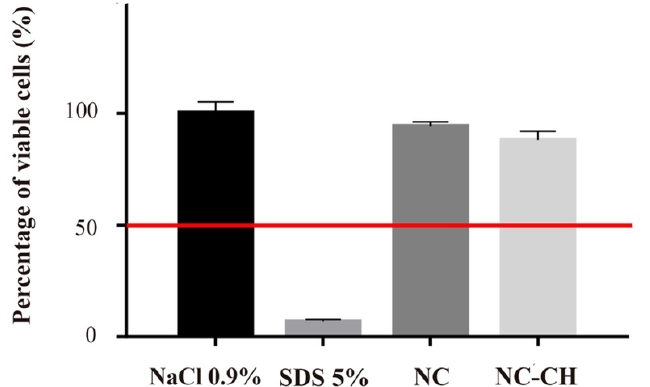
Figure 7. Cell viability percentage after the exposure of Reconstructed Human Epidermis (RHE) to either NC or NC-CH. Positive and negative controls comprised SDS 5% and NaCl 0.9% solutions, respectively. The data represent the means of 3 replicates ± standard deviation.